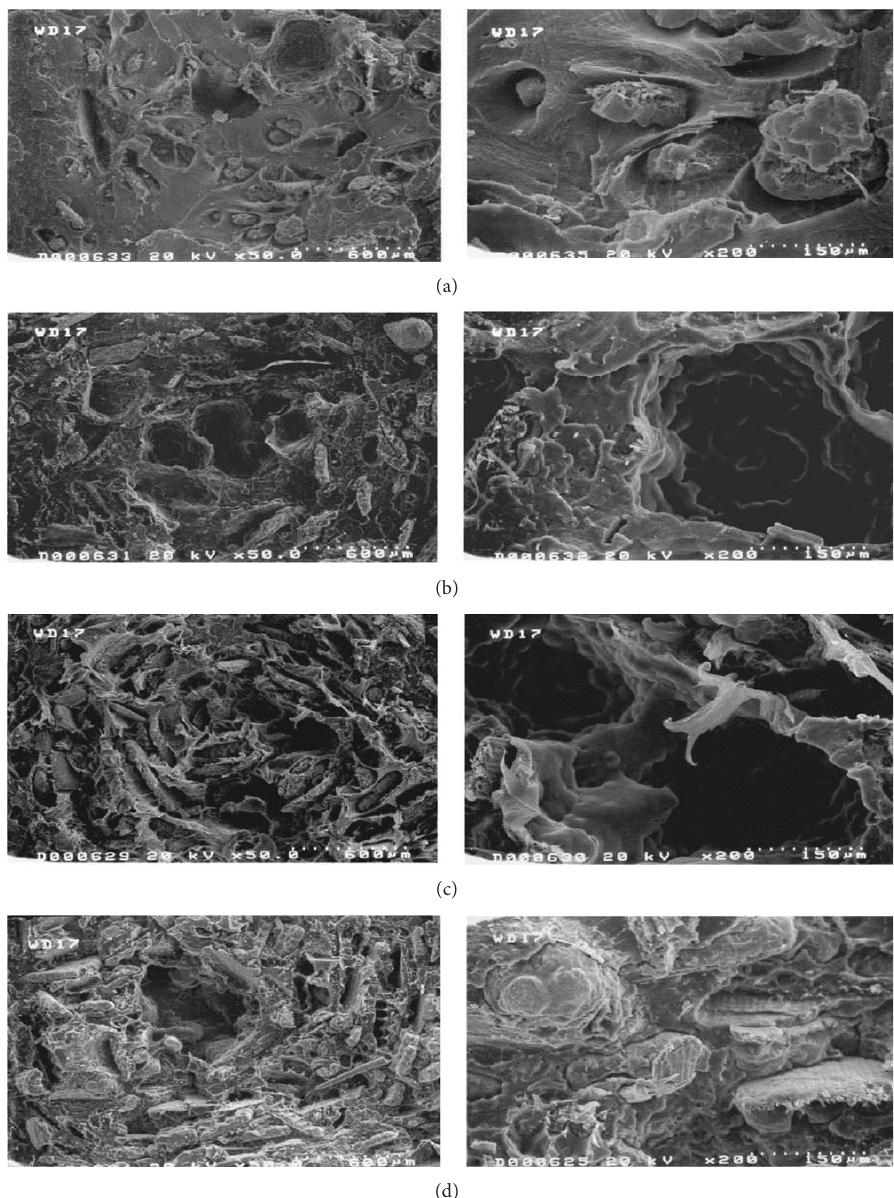
Figure 22: SEM micrographs of the tensile fracture surfaces of the PP/RHF composites with different filler contents: (a) 10, (b) 20, (c) 30, and (d) 40wt% of RHF contents